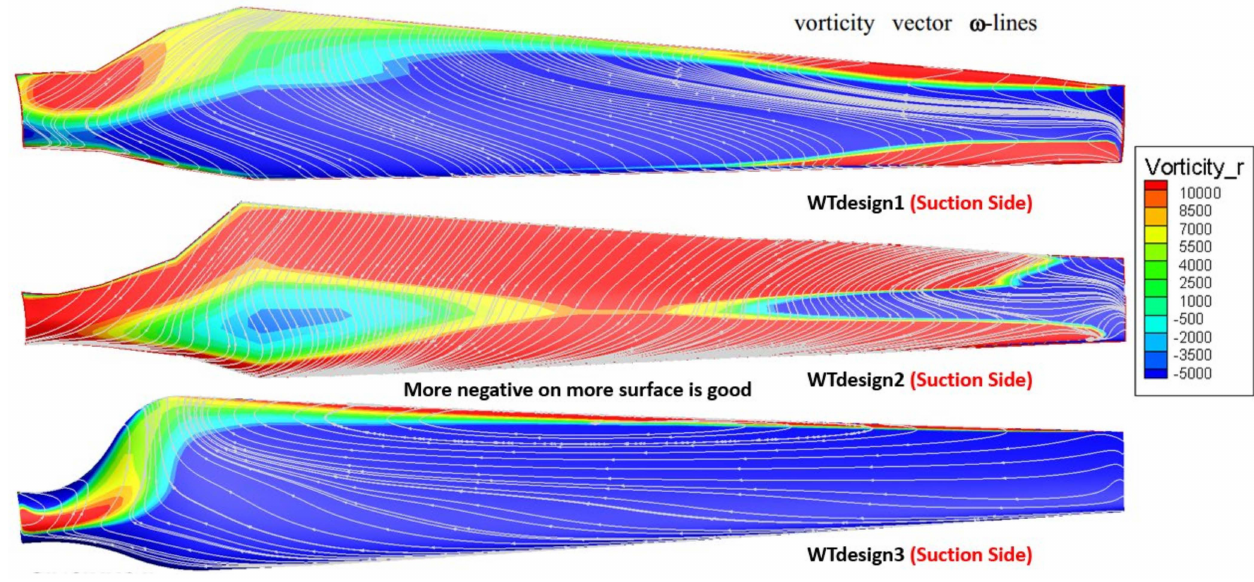
Figure 32. Radial vorticity with vorticity vector and ω lines on design 1, 2 and 3